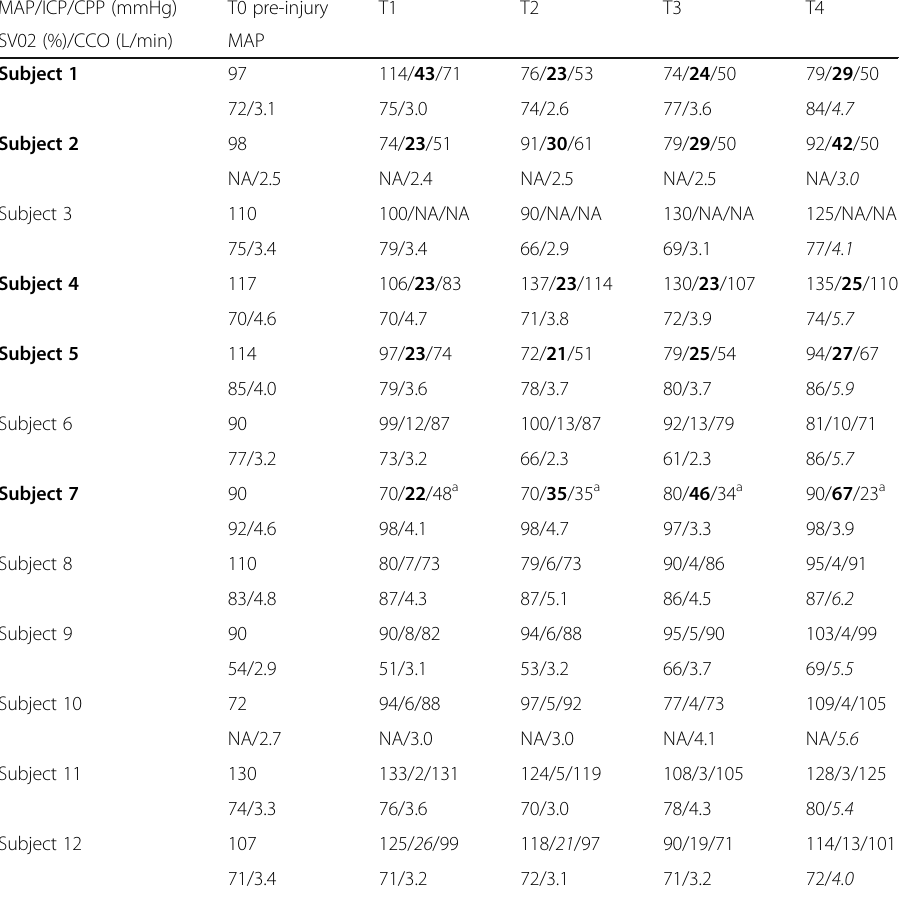
Table 3 Mean arterial blood pressure (mmHg), intracranial pressure and cerebral perfusion pressure (mmHg) mean values in all subjects at each time point MAP/ICP/CPP